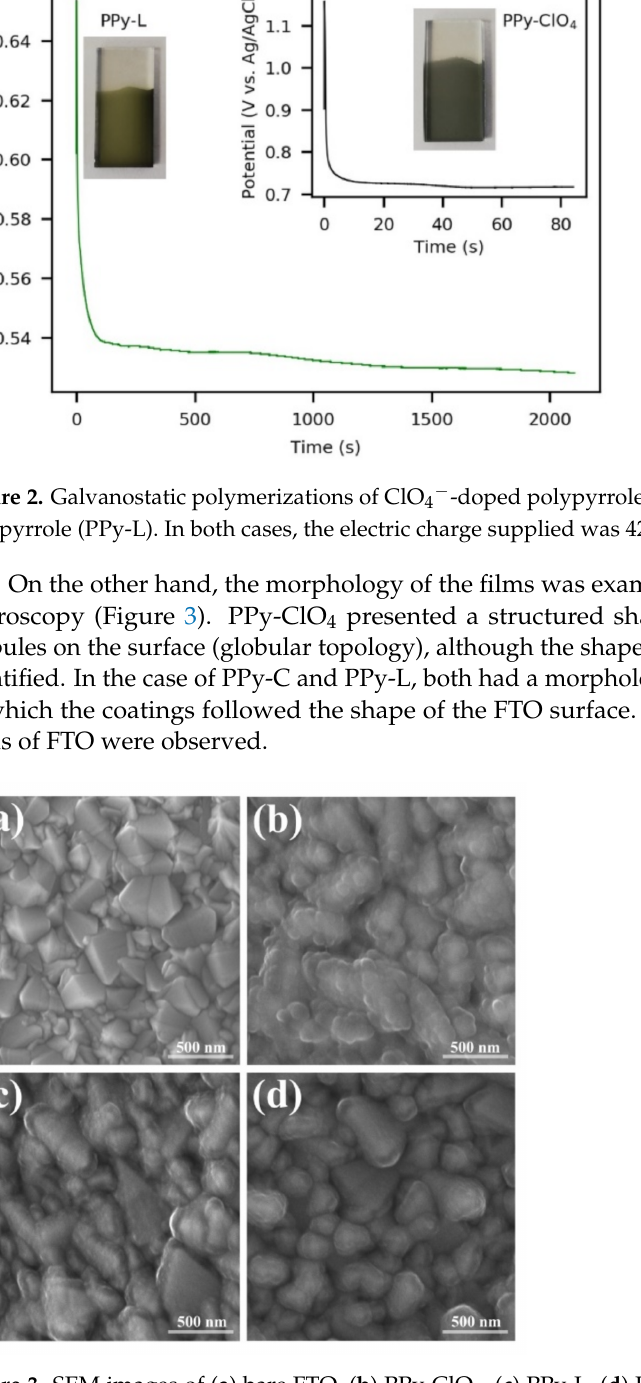
Figure 3. SEM images of ( a ) bare FTO, ( b ) PPy-ClO 4 , ( c ) PPy-L, ( d ) PPy-C. 42 mC/cm 2 of electric charge supplied during